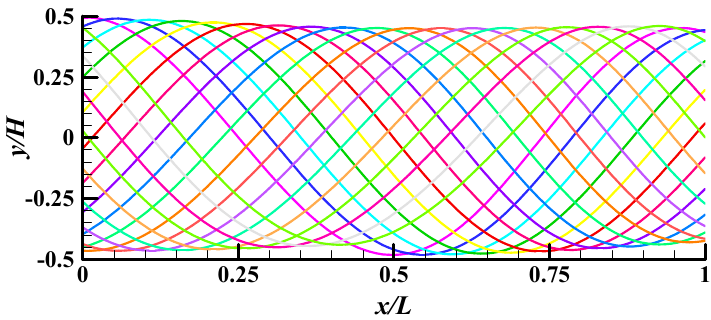
Figure 4. Illustration of a regular progressive wave train.